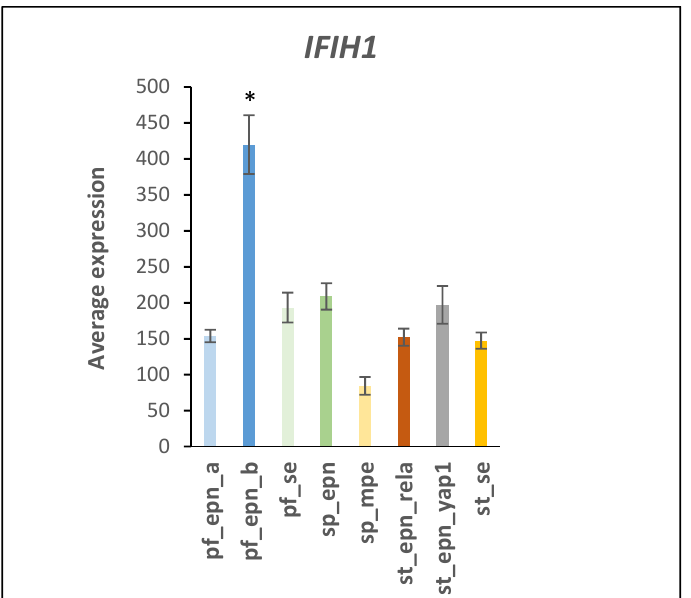
Figure 2. Increased IFIH1 expression in the PF_EPN_B subtype (by Anova, F = 19.36, p = 1.08 × 10 − 19 ). * significantly different from all other groups by t -test p < 0.01. Dataset GSE64415. Table 3. Main Reactome Reactions over-represented by differentially expressed E2 conjugase genes. Four differentially expressed ubiquitin E2 conjugase genes ( UBE2C , UBE2S , UBE2D1 , UBE2E1 ) contributed to 22 Reactome pathways statistically associated with the anaphase promoting complex/cyclosome (APC/c) pathway (Table 2) and to 37 Reactome Reactions Gene (Table 3). UBE2C (aka UBCH10 ) and UBE2S work in tandem [13–15] and their role in cell